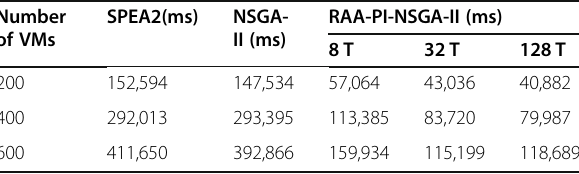
Table 7 Solving time of the multi-objective evolutionary